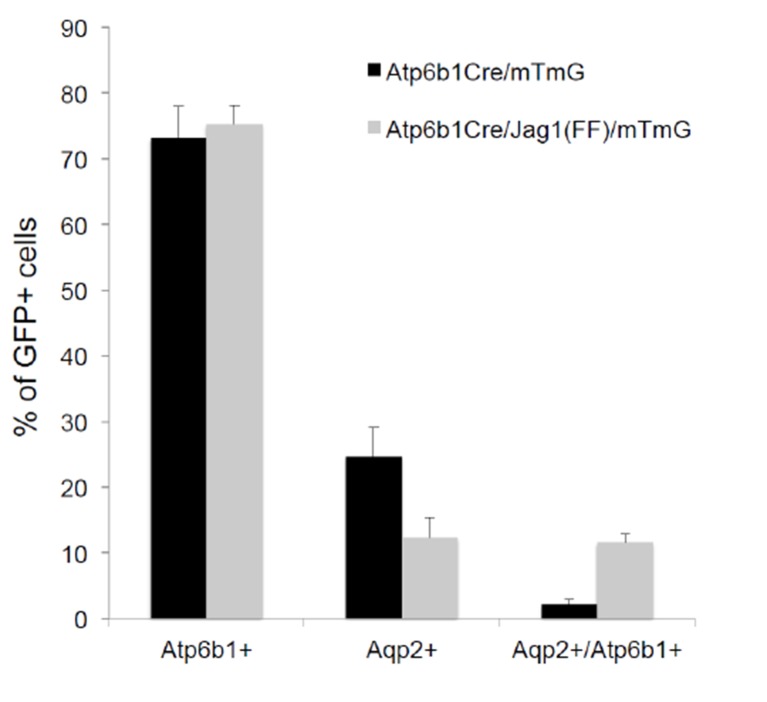
Deletion of Jag1 in IC (Jag1f/f;Atp6b1-Cre;mTmG) resulted in a six fold increase in ‘double positive’ cells (from 2% to 12%; n = 3 independent mice).Only Atp6b1Cre driven GFP+ cells were assayed.